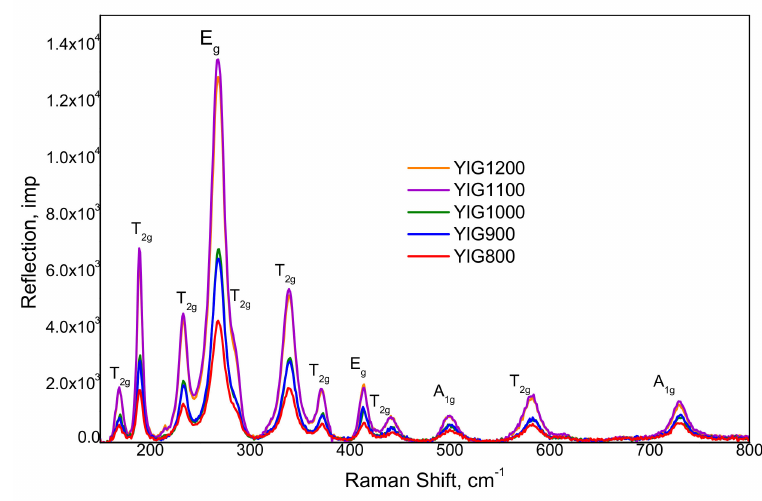
Figure 3. Raman spectra of synthesized YIG